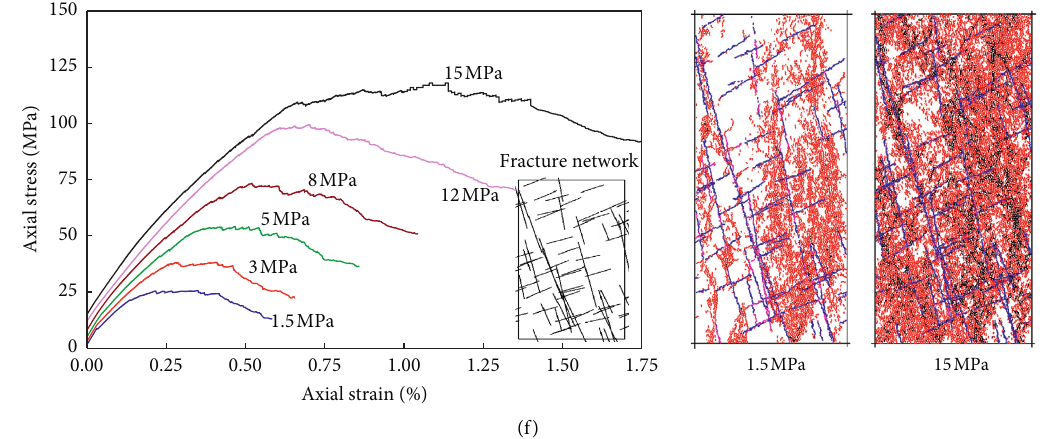
Figure 16: Stress-strain curves and failure modes of the specimen of size 5 × 10 m under different confining pressures. (a) DFN0. (b) DFN30. (c) DFN60. (d) DFN90. (e) DFN120. (f) DFN150. Note that the blue line is the SJM tensile crack, the magenta line is the SJM shear crack, the red line is the FJM tensile crack, and the black line is the FJM shear